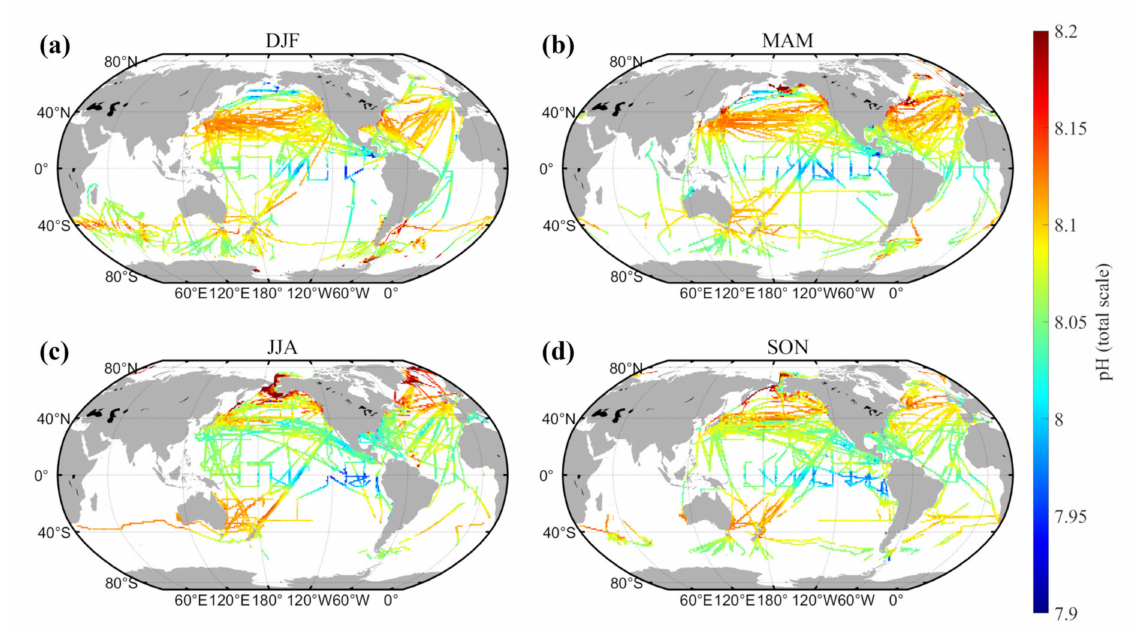
Figure 18. Global spatial distribution of seasonal sea surface pH. The letters at the top of each panel represent the initials of the months of the year: ( a ) for December to February, ( b ) for March to May, ( c ) for June to August, and ( d ) for September to November.